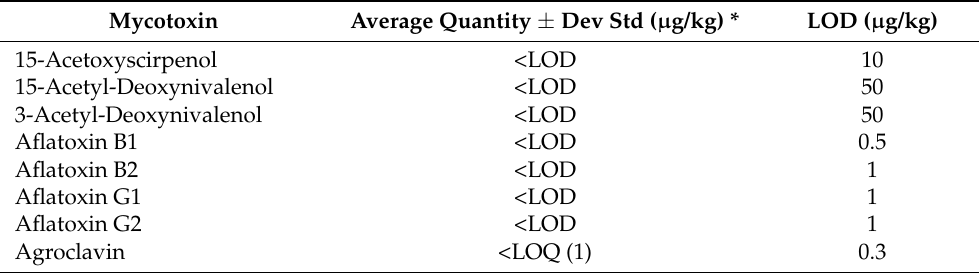
Table 5. Mycotoxin average quantity and standard deviation calculated on three samples of rye flour used for bread production. On the third column the LODs of the method are